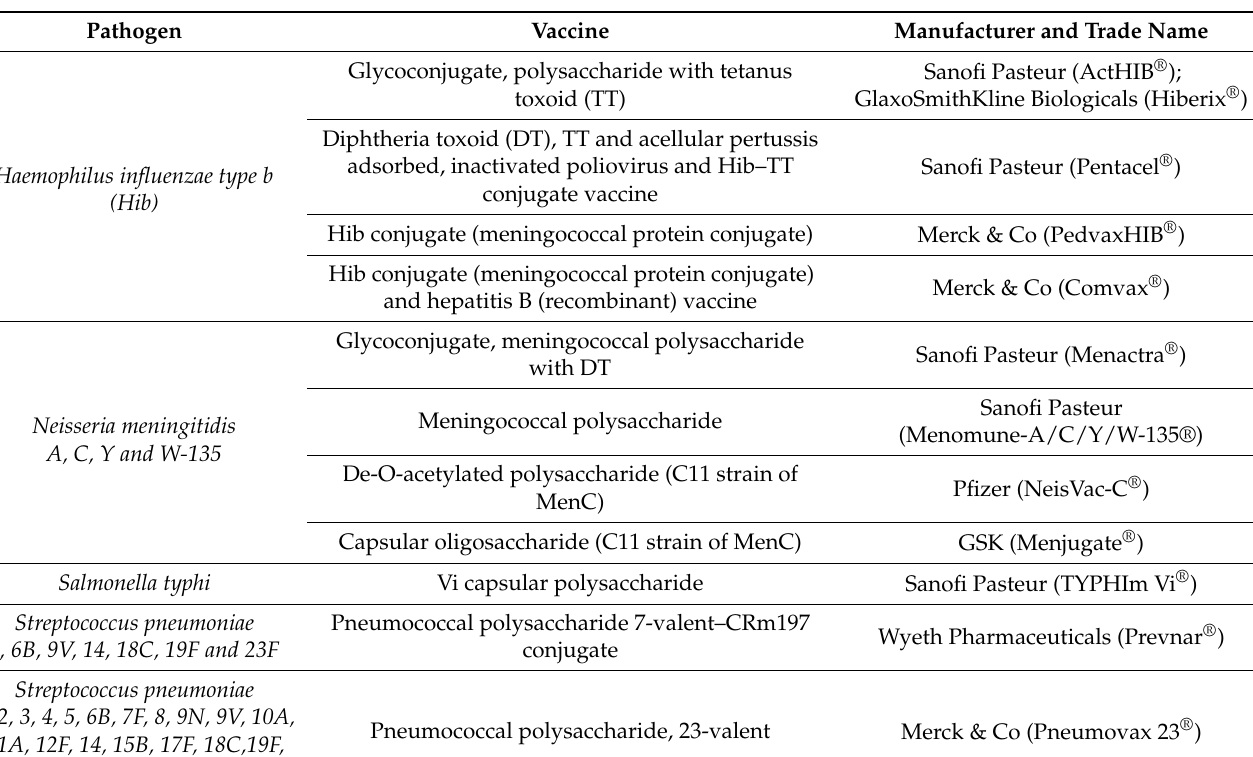
Table 3. Approved carbohydrate-based vaccines; a selection from FDA-approved vaccines.